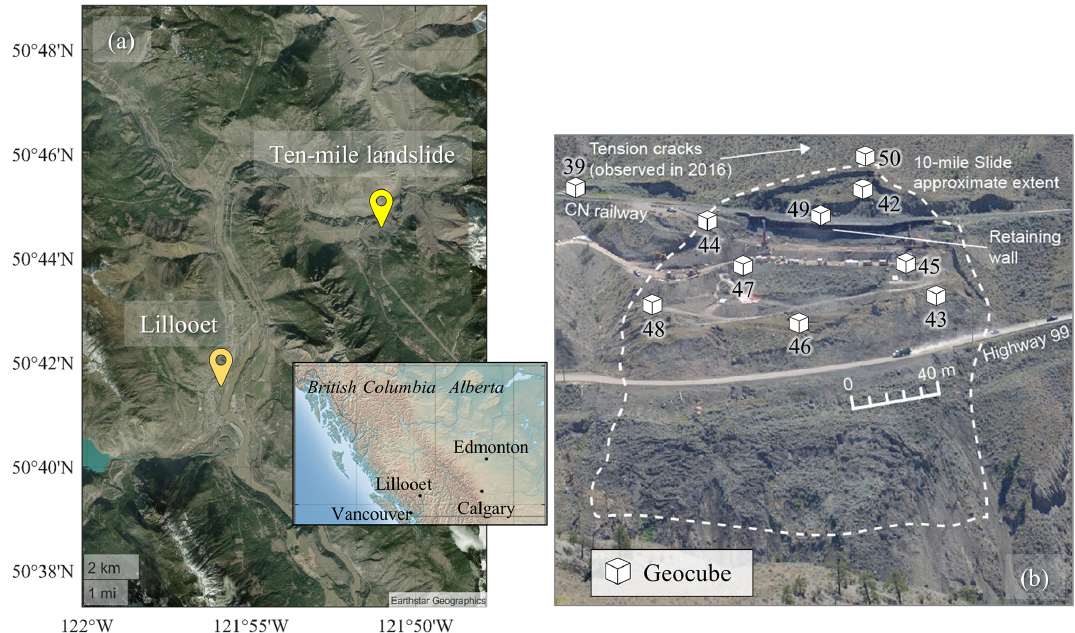
Figure 5. (a) Location of the Ten-mile landslide (source: Earthstar Geographics LLC) and (b) front view of the Ten-mile landslide and distribution of Geocubes on its surface (Rodriguez et al., 2018; Macciotta et al., 2017b).